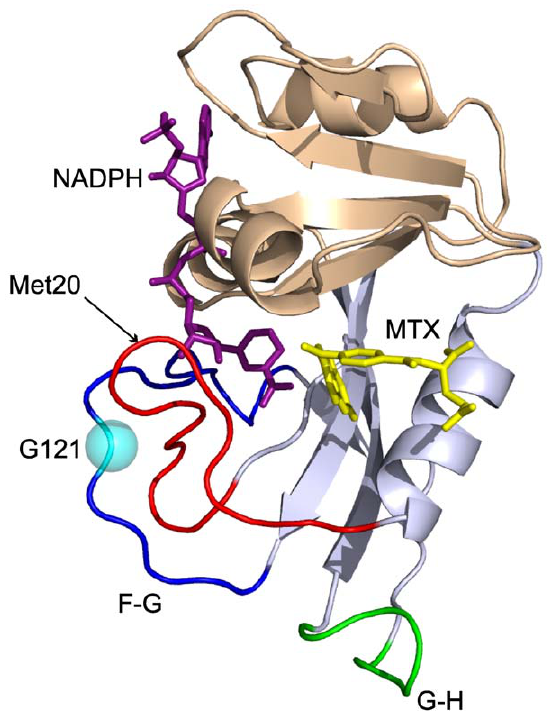
Figure 1. DHFR subdomain and loop nomenclature. Structure of DHFR complexed with NADPH (purple) and methotrexate (yellow) (pdbid 1RX3). Adenosine binding domain is shown in light blue while the loops domain is shown in wheat. The Met20 (red), F–G (blue), G–H (green) loops are labeled. The site of mutation (G121V) is indicated by a cyan sphere.